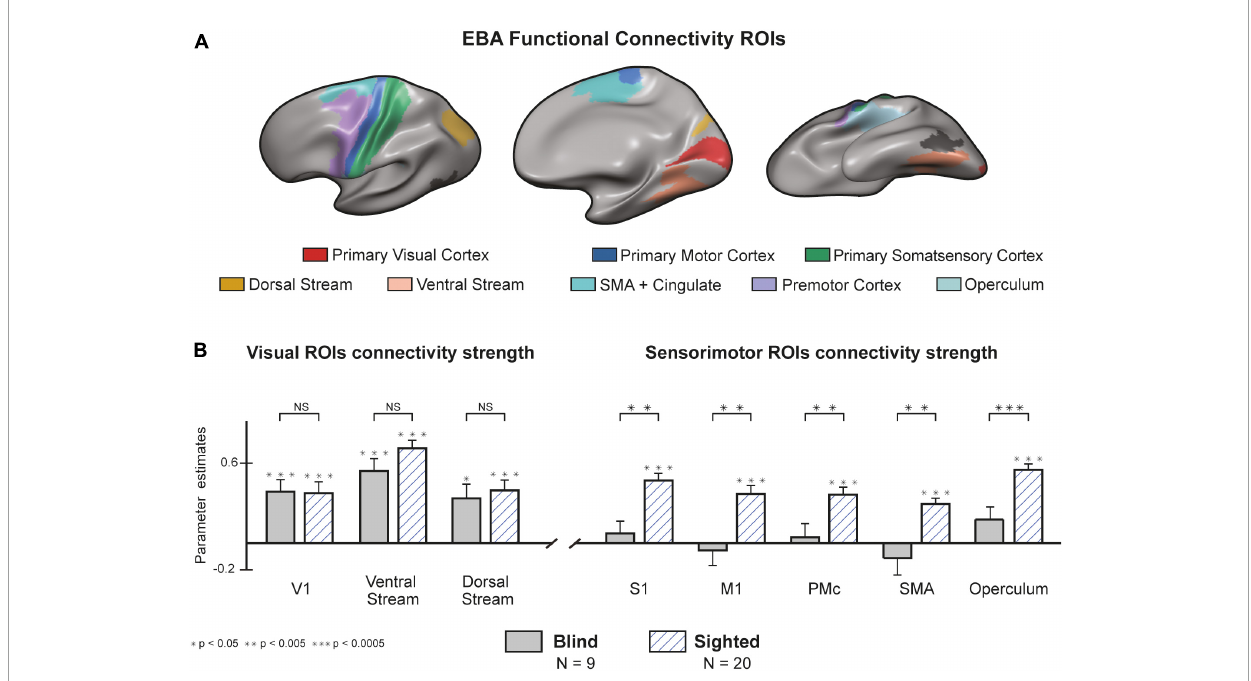
FIGURE4 There is a functional disconnection between the blind Extrastriate Body Area (EBA) and sensorimotor cortices. (A) Regions of Interest (ROIs) from the Human Connectome Project (HCP) atlas (Glasser et al., 2016). A full cytoarchitectural breakdown of each area is in Supplementary Table 3 . (B) Congenital blindness alters EBA’s connectivity profile. Seed-to-seed analysis of connectivity strength from the EBA to sensorimotor and visual seeds. In both groups, resting-state connectivity to visual cortices was significantly higher than the baseline. Connectivity to sensorimotor regions was significantly higher in the sighted compared to the blind group (random effects GLM, n = 29). We found similar results when analyzing the connectivity from EBA to the right and left hemispheres separately ( Supplementary Figure 8 ). Error bars are for the standard error. Large asterisks indicate between-group significance, small asterisks indicate within-group significance against the baseline. NS,